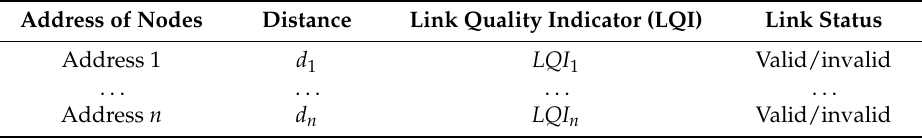
Table 1. Route discovery neighbor table of the forward/backward